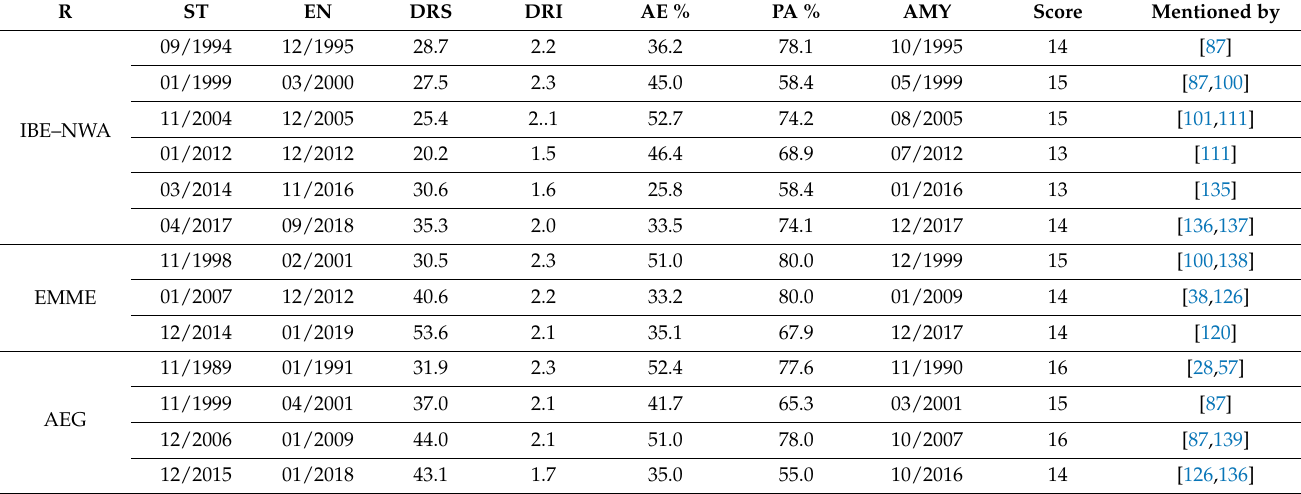
Table 7. A list of exceptional subregional drought events across the MED detected by DXI-12 that were identified according to the new grade classification during